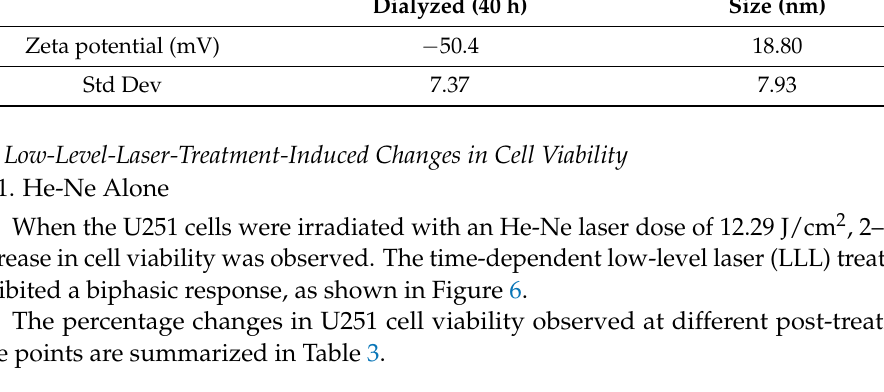
Table 3. Cell death induced by low-level laser treatment in U251